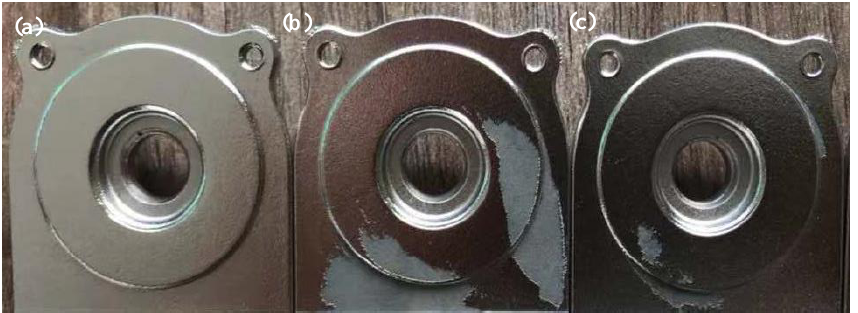
Figure 11. Digital macrographs of PEI samples: ( a ) standard condition (4 min), ( b ) short acceleration time (2 min), ( c ) excessive acceleration time (10 min).